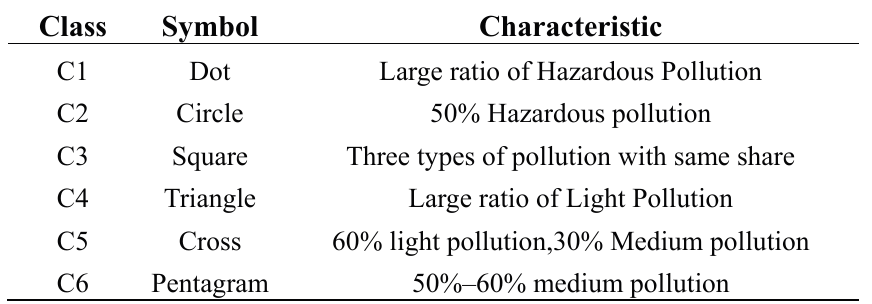
Table 4. Characteristic of each PM 2.5 Pollution Episode in different clusters.